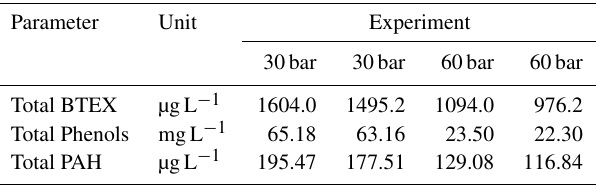
Table 1. Average concentrations of organic compounds of the in situ gasification wastewater of the Máza-Váralja coal bulk samples. Parameter